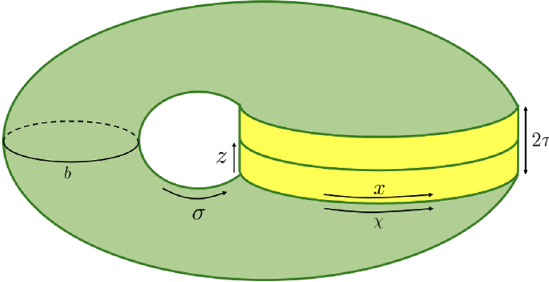
Figure 9 . An illustration of a bra-ket wormhole in the compact spatial direction case. The minimal geodesic length of the wormhole is given by b